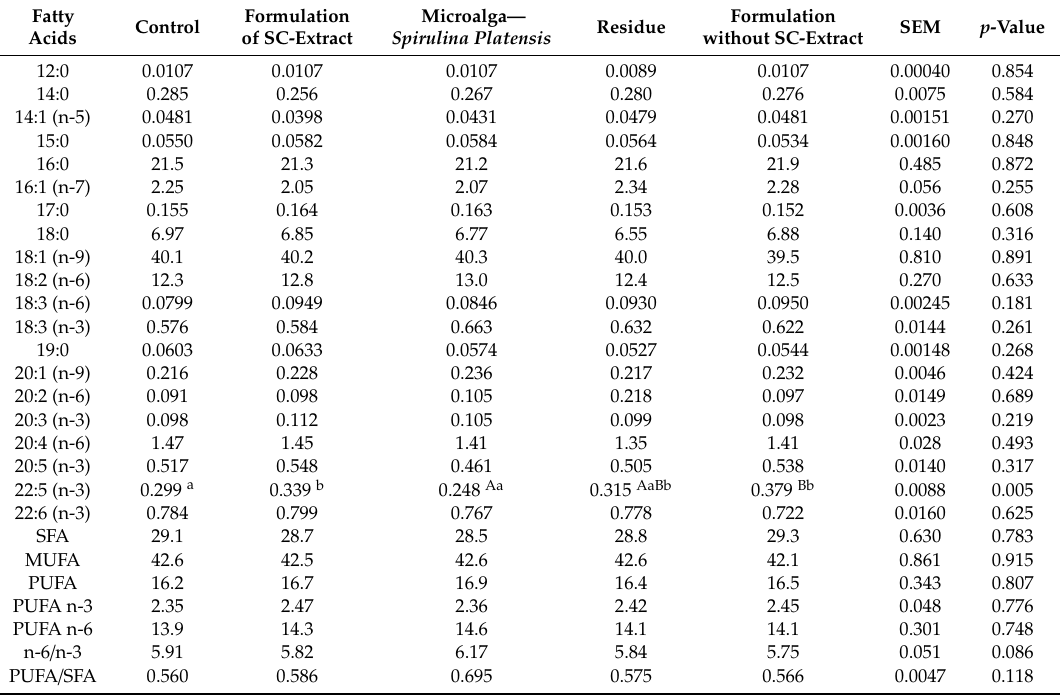
Table 6. The content of FAs in the eggs (% weight of FAs in the sample) after 60 days of the experiment. Formulation Formulation Microalga— Fatty SEM p -Value Residue Control Spirulina Platensis without SC-Extract of SC-Extract Acids